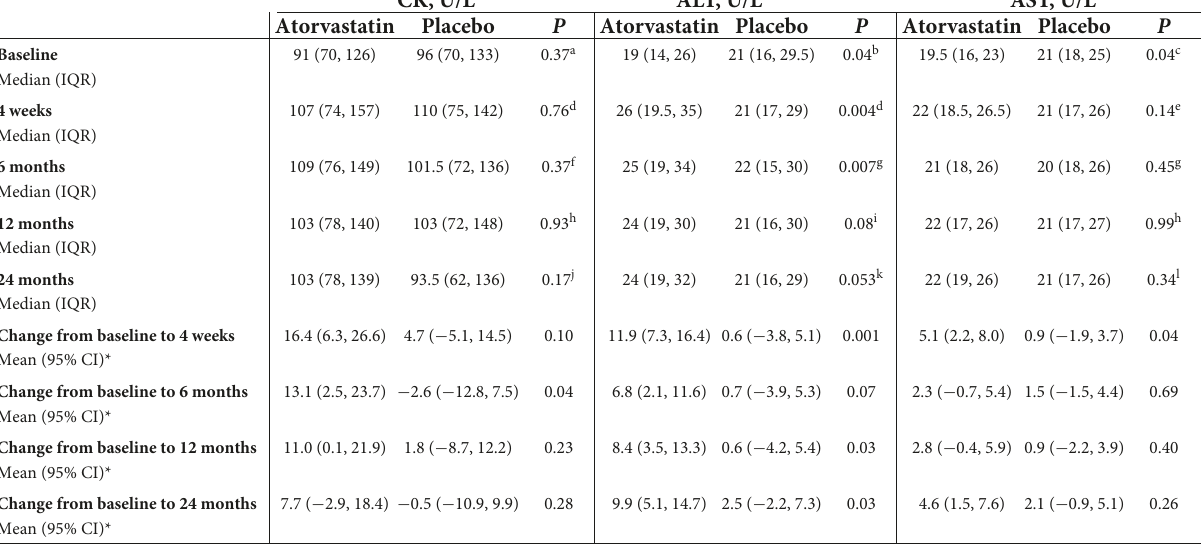
TABLE 2 Muscle biochemistry biomarkers over 2 years.